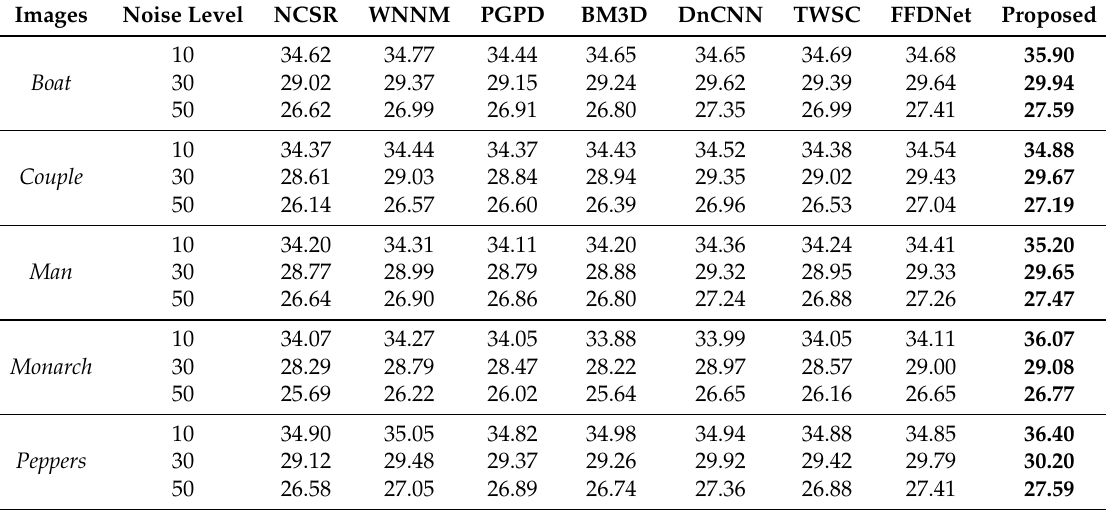
Table 1. Comparison of denoising results in terms of PSNR (dB) for five selected test images.